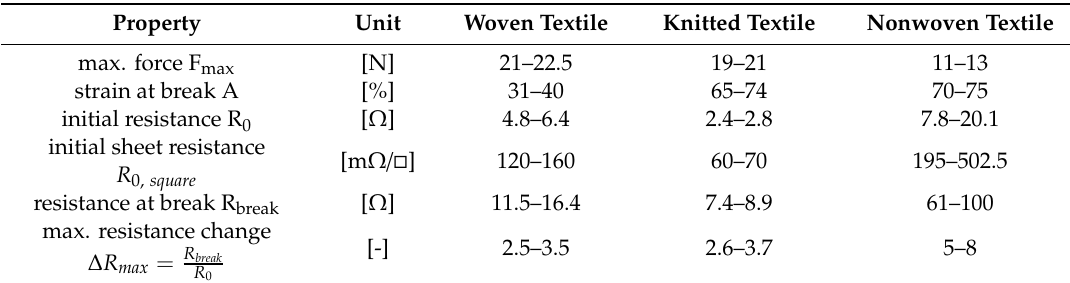
Table 4. Mechanical and electrical properties of tested elastic textile/polymer composite-based stretchable circuit boards.